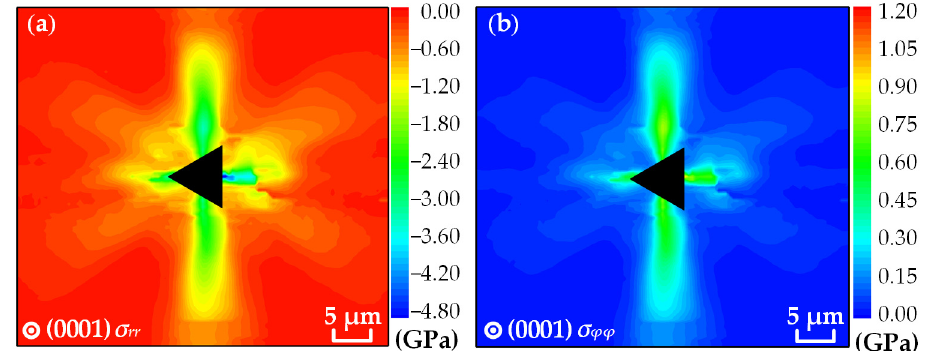
Figure 9. Distributions of ( a ) radial stress σ rr and ( b ) tangential stress σ ϕϕ .